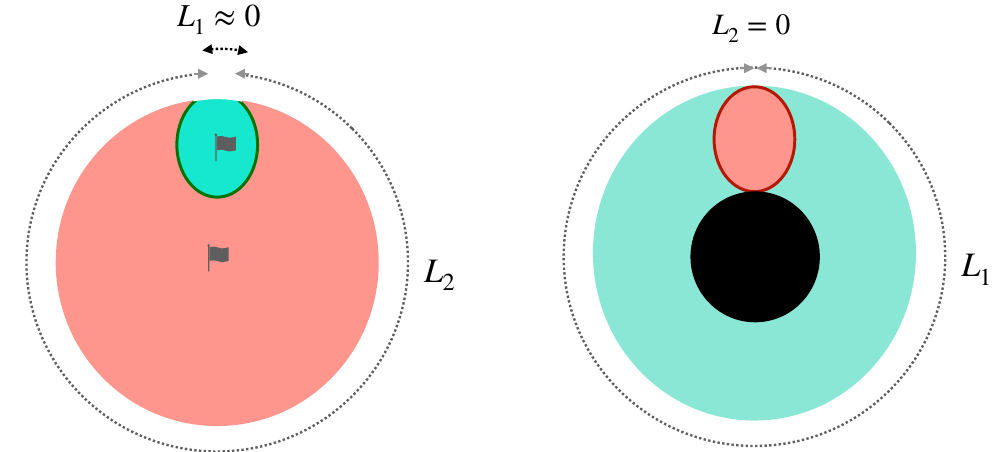
Figure 9 . Left: a bubble of true vacuum that survives inside the false vacuum despite the fact that its conformal boundary shrinks to a point. Right: a bubble of false vacuum with λ = λ between the boundary and the horizon of a black